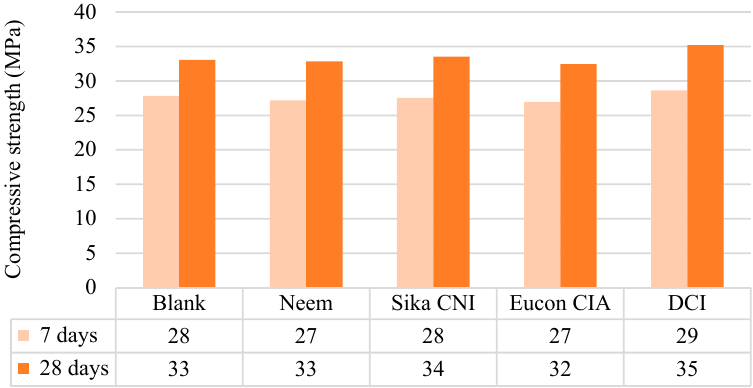
Figure 5. Compressive strength.